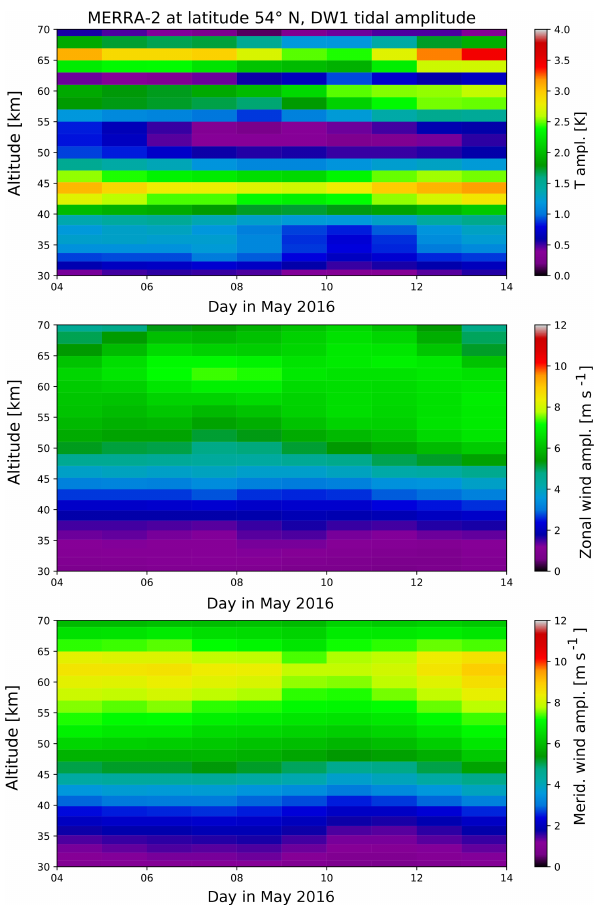
Figure 11. SW2 amplitude in temperature, zonal and meridional wind from global MERRA-2 fields at the latitude of 54 ◦ N.